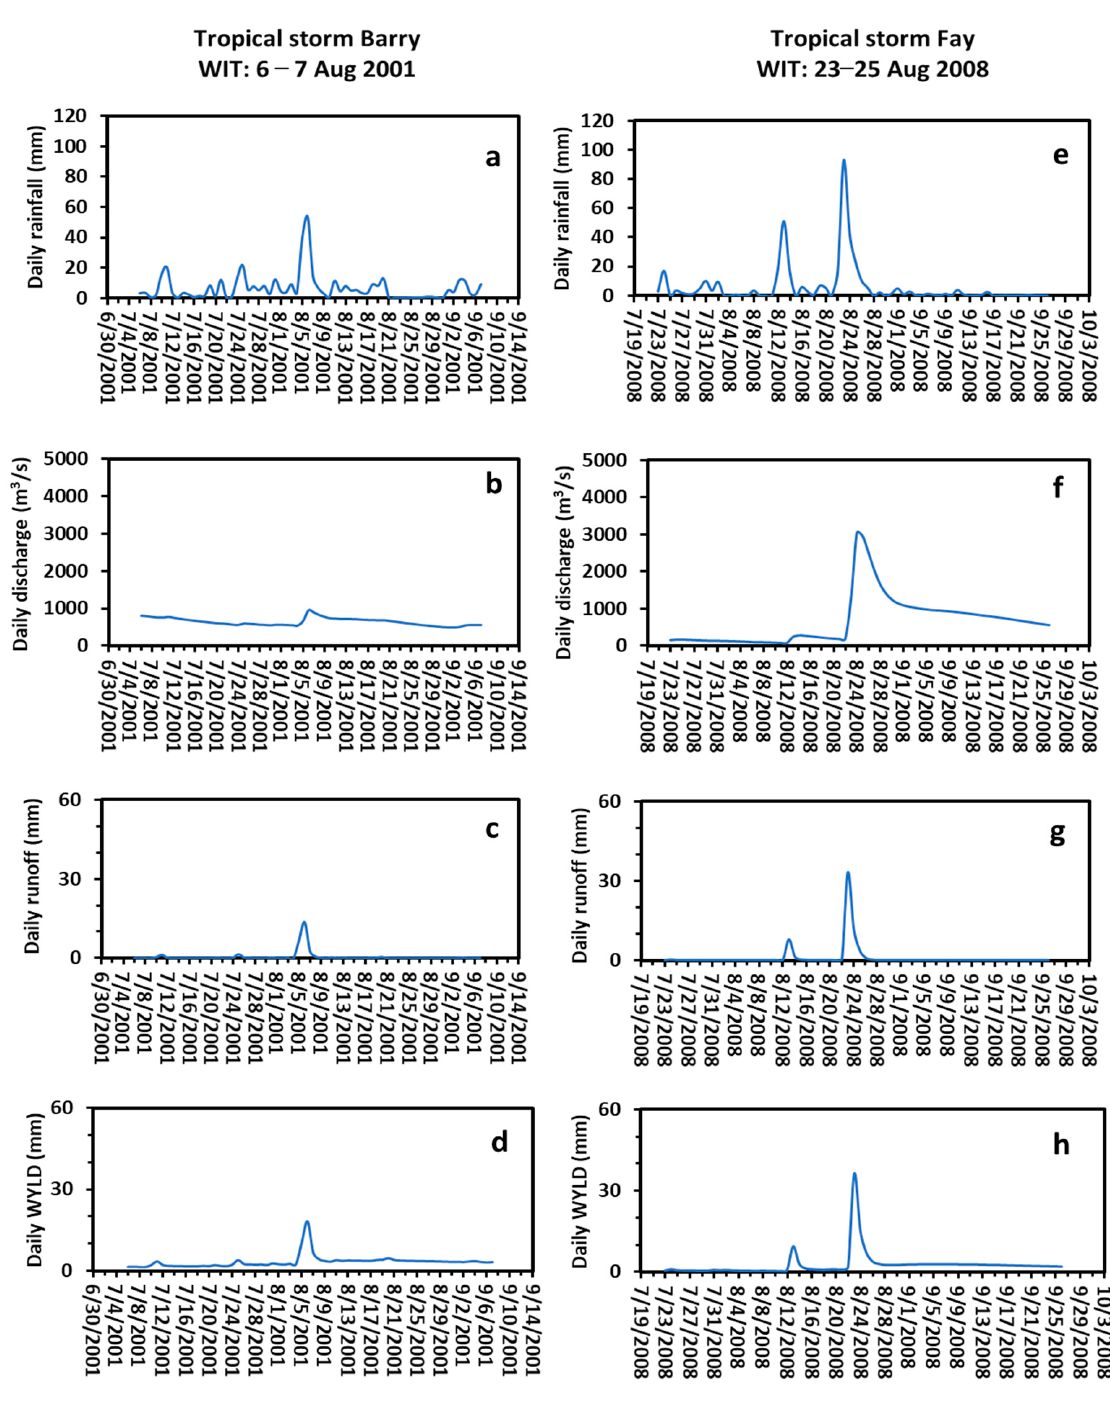
Figure 5. Daily rainfall, stream discharge, surface runoff and water yield (WYLD) under tropical storms Barry and Fay. WIT is the watershed impact times.